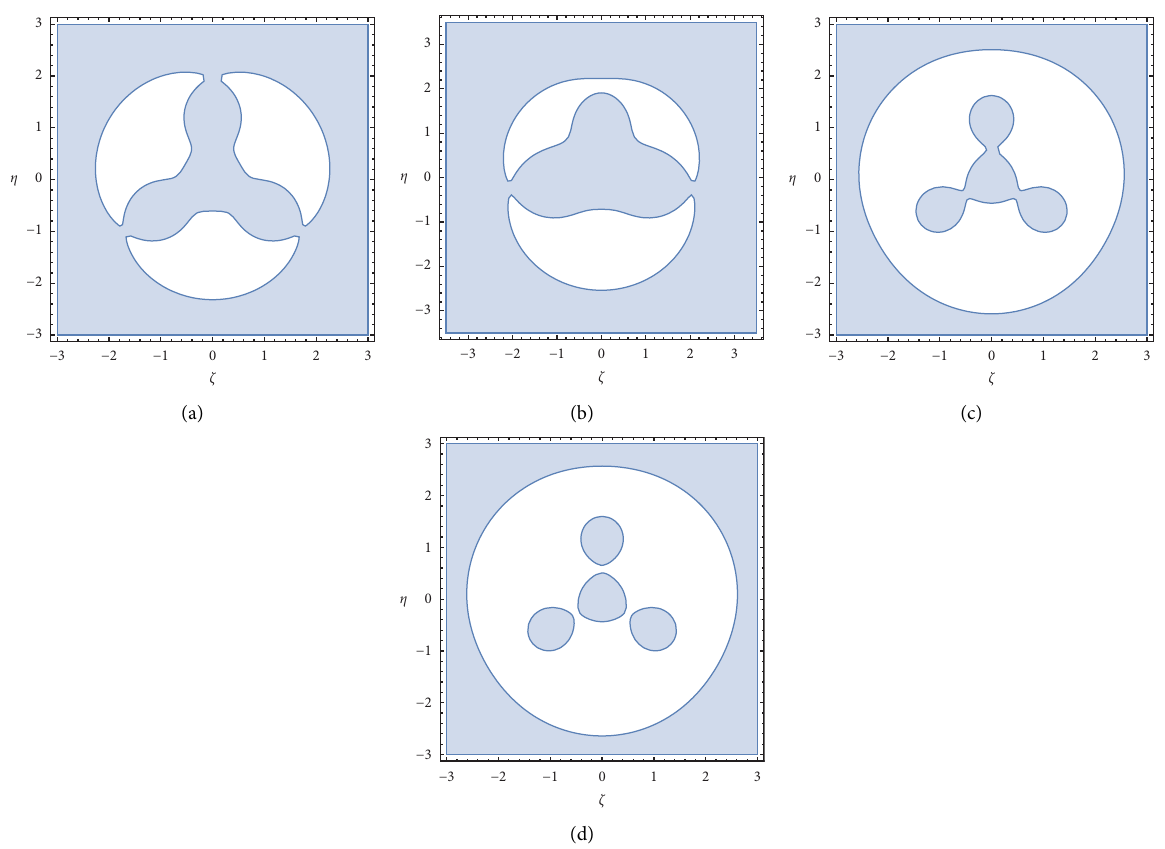
Figure 9: Case II: regions of motion for m